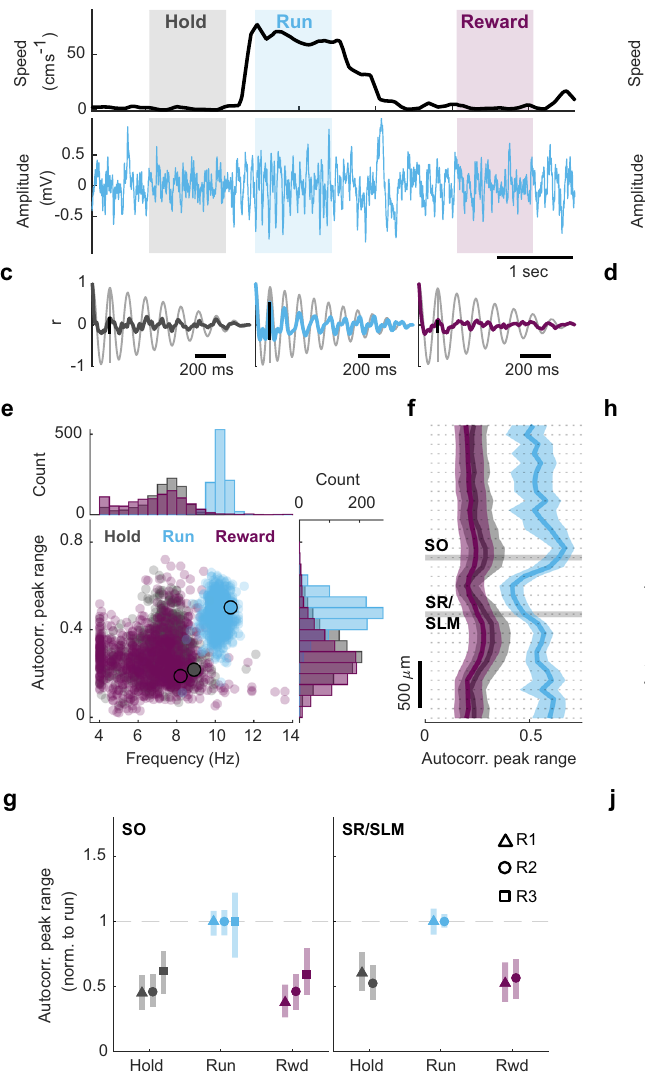
from a one second epoch from a single trial; data are from all sessions. Markers edged with black show the position of example epochs shown in c . f Autocorrelation peak range for Hold (grey), Run (blue) and Reward (purple) epochsacrossallprobechannelsforratR1;dataarefromallsessionsandpresented as median (solid line) and interquartile range (shaded area). Channels in the stra- tum oriens (SO) and stratum radiatum/stratum lacunosum moleculare (SR/SLM) are highlighted with horizontal light grey shading. g Normalised autocorrelation peakrangeforHold(grey),Run(blue)andRwd(reward;purple)epochsforeachrat (R1 n =1081, R2 n =368, R3 n =427 trials) in the SO (left plot) and SR/SLM (right plot).Dataarepresentedasmedian(markerposition)andinterquartilerange(error bars) and normalised to the median Run value; data are from all sessions. h, i as in e – f but for ferret F3 L . j as in g but for ferret probes (F1 L n =430, F1 R n =236, F2 L n =421, F3 n =272, F3 n =682 trials). For h – j ferret Run data are presented in L R